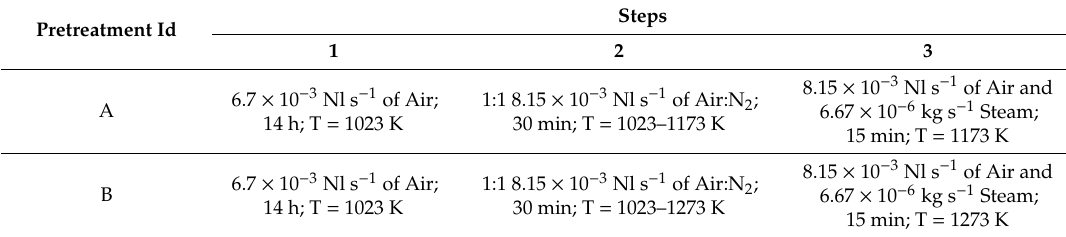
Table 1. Conditions of the two different applied pretreatments.